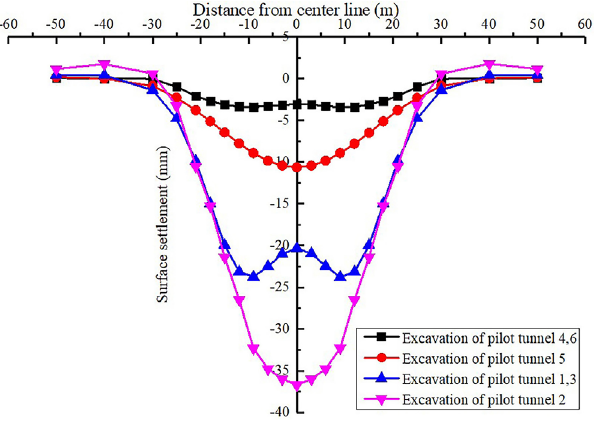
Figure 10. Plots of settlement troughs during pilot tunnel construction.